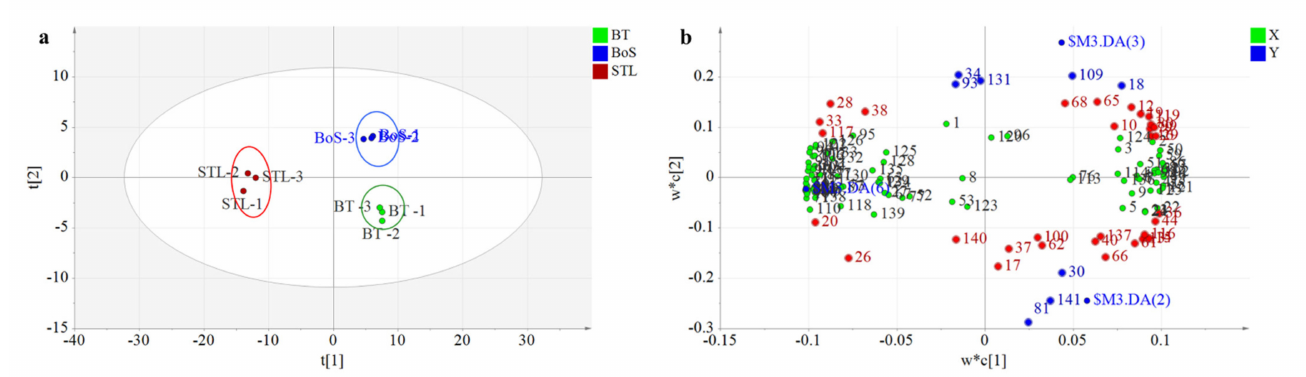
Figure 2. Partial least-squares discriminant analysis score plot ( a ) and loading plot ( b ) for volatile metabolites (VMs) in BT, STL, and BoS samples. STL, Strobilanthes tonkinensis Lindau; BT, black tea; BoS, black tea with added STL. SMI.DA(1), Strobilanthes tonkinensis Lindau (STL); SMI.DA(2), black tea (BT); SMI.DA(3), BT with added STL (BoS). Longitudinal data represent 141 VMs, and horizontal data represent three tea samples. Red represents high metabolite content, and blue represents low metabolite